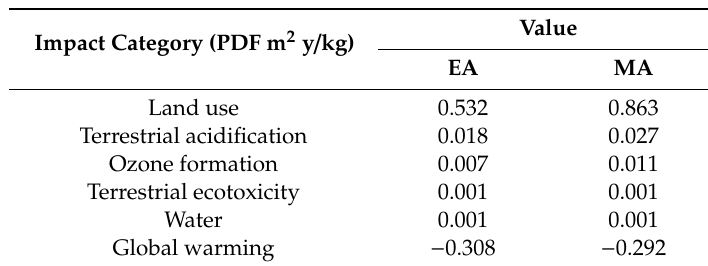
Table 4. Terrestrial ecosystem damage (PDF m 2 y / kg) from the production of 1 kg of hemp shiv, based on hierarchist perspective. EA and MA show the results based on economic and mass allocation,